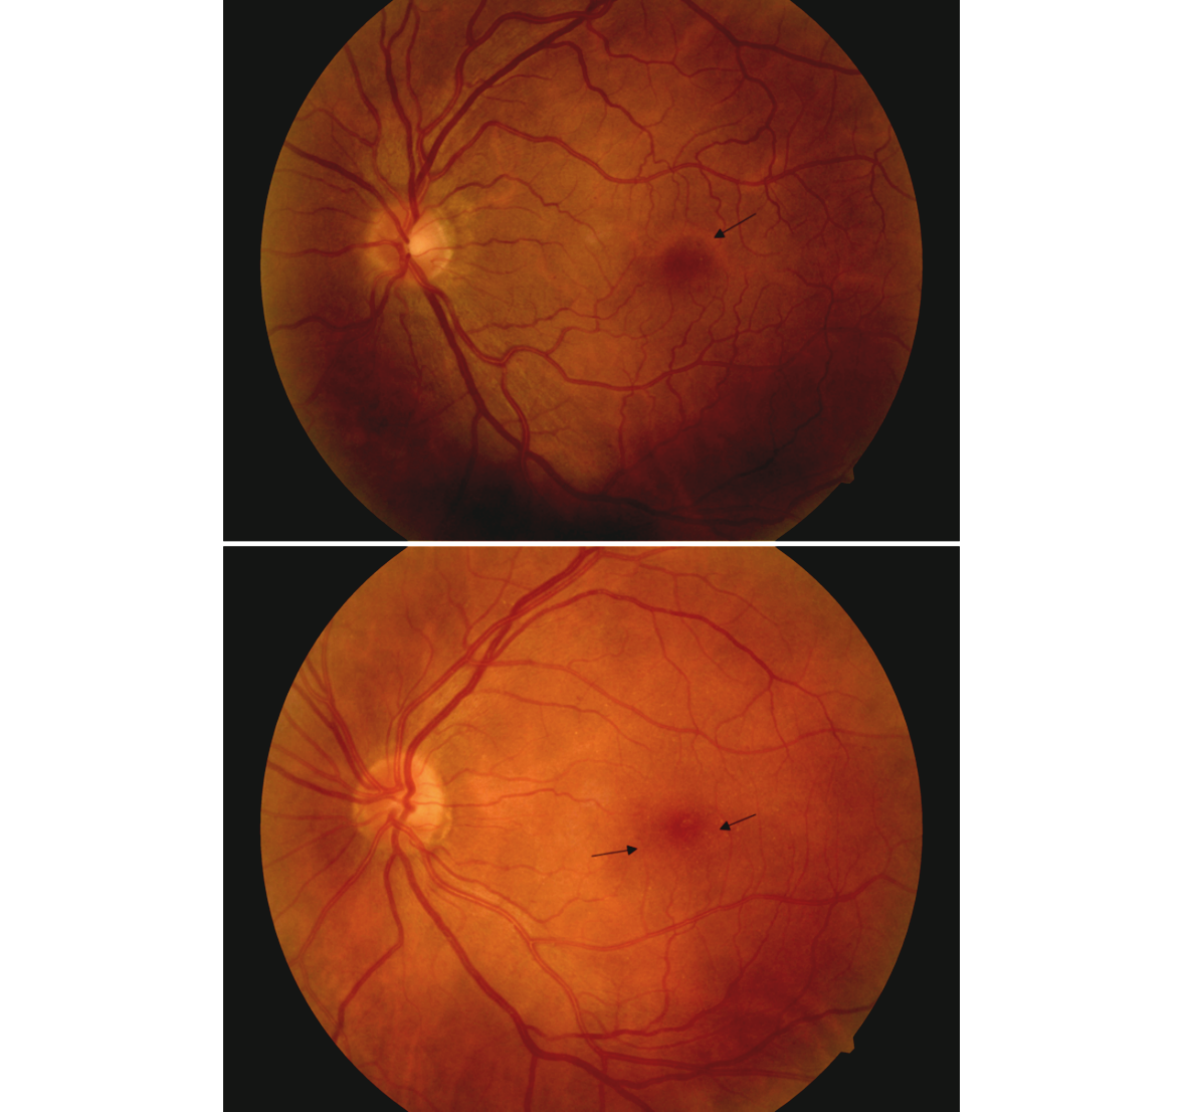
Figure 3. Two challenging cases of an isolated microaneurysm near the fovea. Arrows are used to indicate the location of